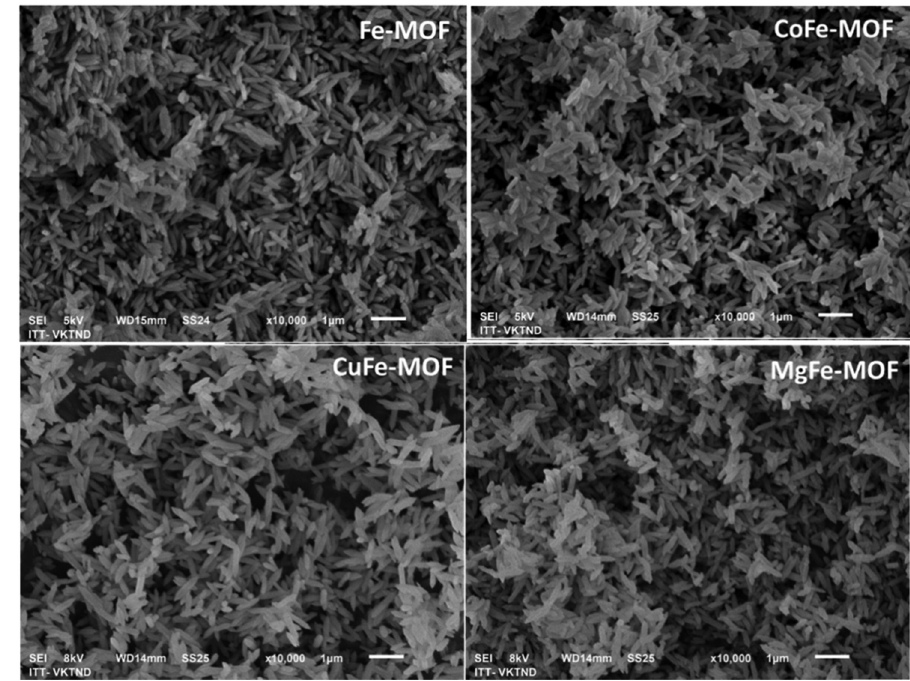
Figure 3: SEM images of M/Fe - MOF ( M = Co, Cu, and Mg )